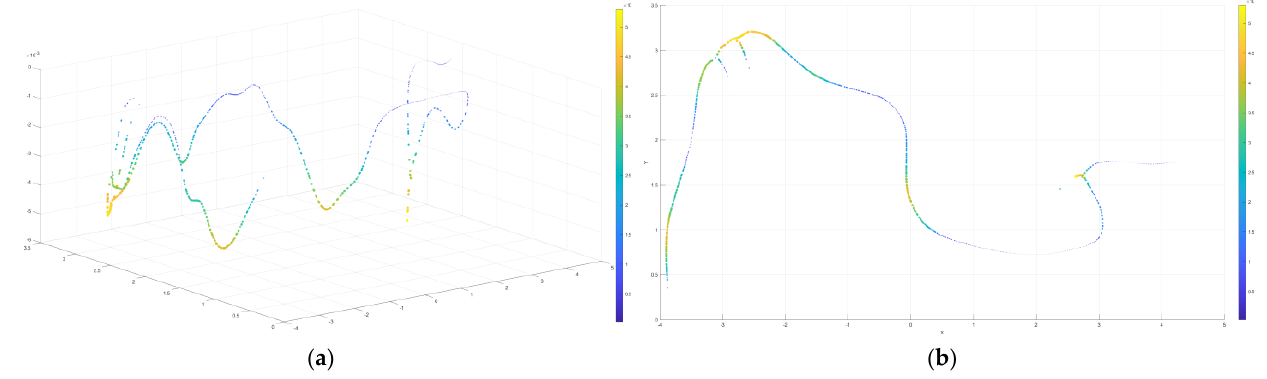
Figure 10. The 3D skeleton sample point visualization display: ( a ) shows the skeleton sample points in 3D space; ( b ) shows the skeleton sample points in the x − y view. The color indicates the depth of the point, i.e., the z − value of each point. The darker the color, the shallower the depth of the point, and the brighter the color, the deeper the depth of the point. is the same as that of the sampled points, i.e., the position of each sample point does not change, but the weight of each edge increases and the nature of the corresponding point changes, resulting in a change in the overall volume of the worm tract, as shown in Figure 11.